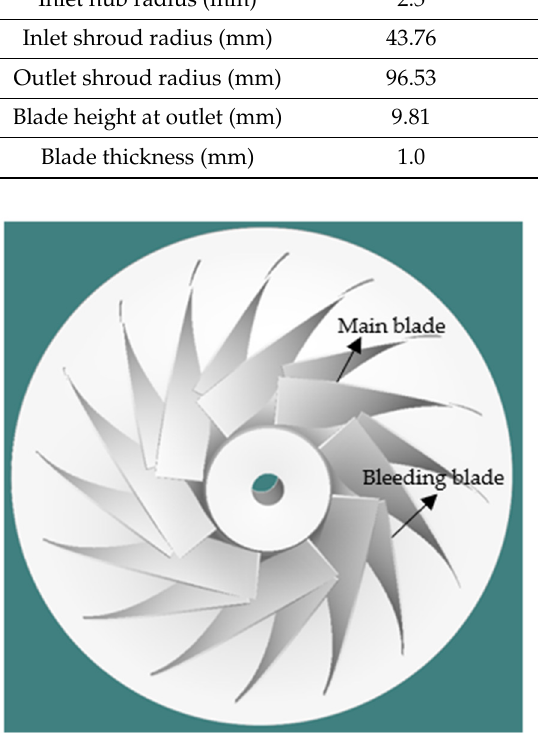
Figure 3. Three-dimensional geometric